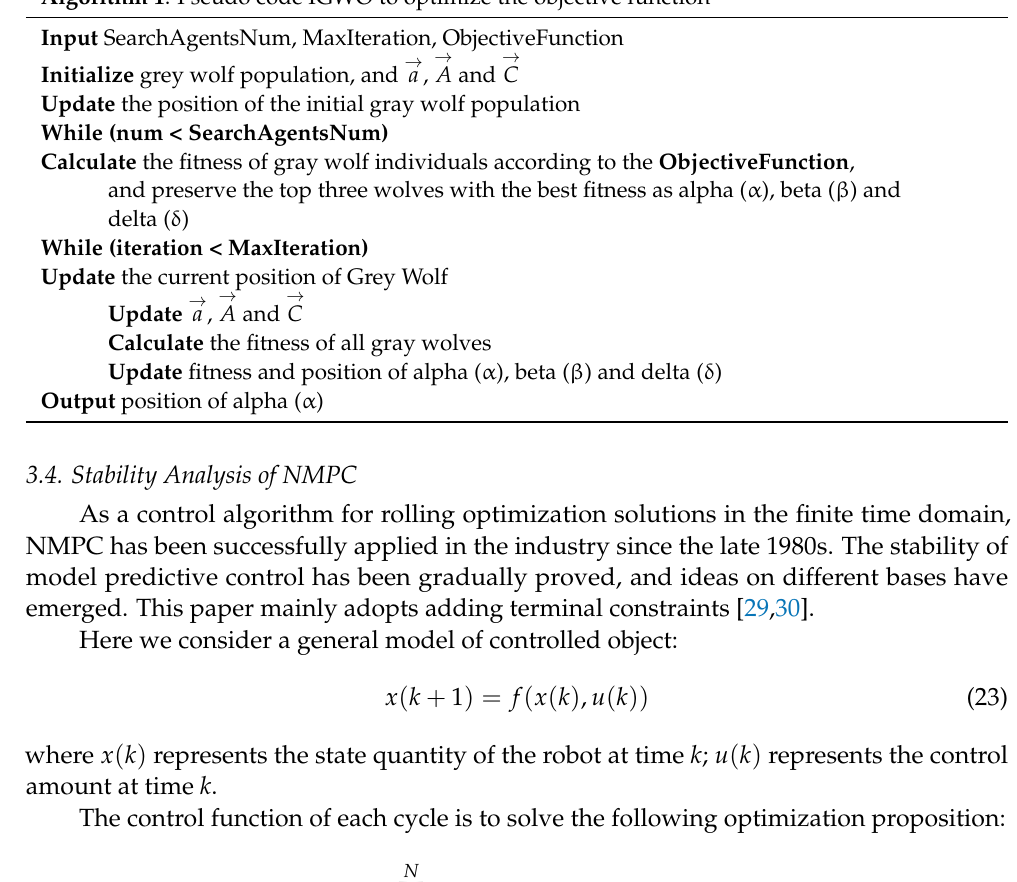
Algorithm 1 . Pseudo code IGWO to optimize the objective